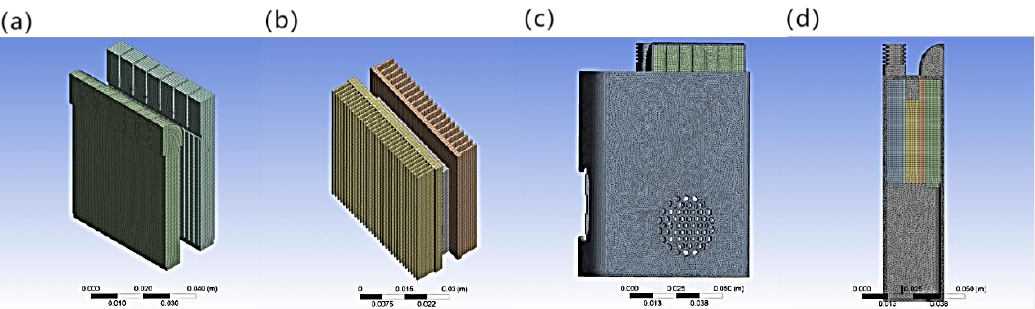
Figure 10. Finite element analysis meshing: ( a ) fluid domain; ( b ) solid domain; ( c ) solid domain and fluid domain as a whole; ( d ) solid domain and fluid domain cross–section.